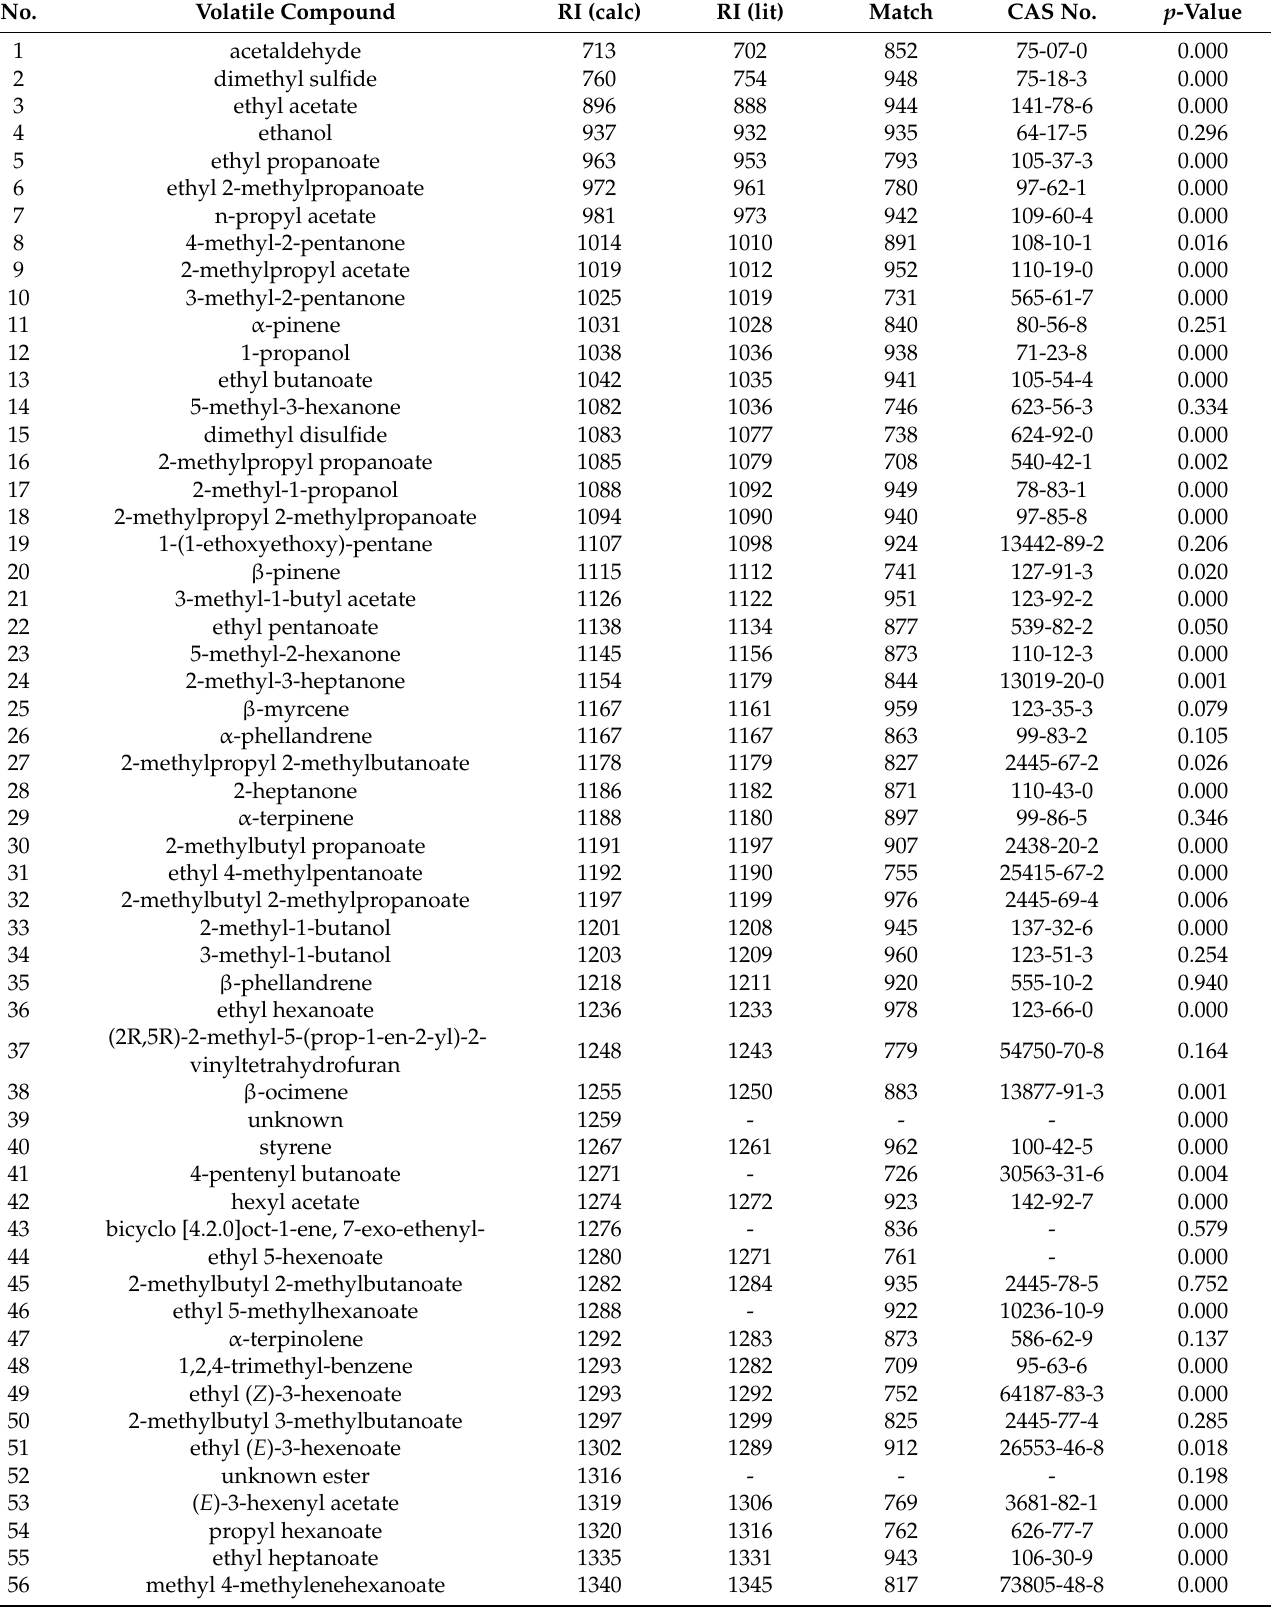
Table A2. Volatile organic compounds identified in twelve beer